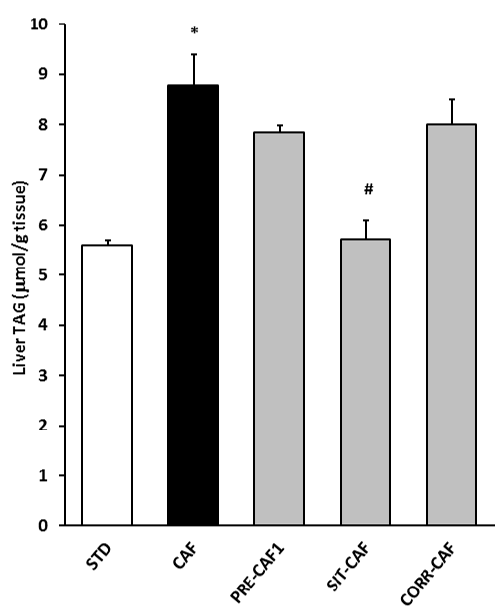
Figure 4. Liver triglyceride reduction after simultaneous and intermittent (SIT-CAF) treatment with